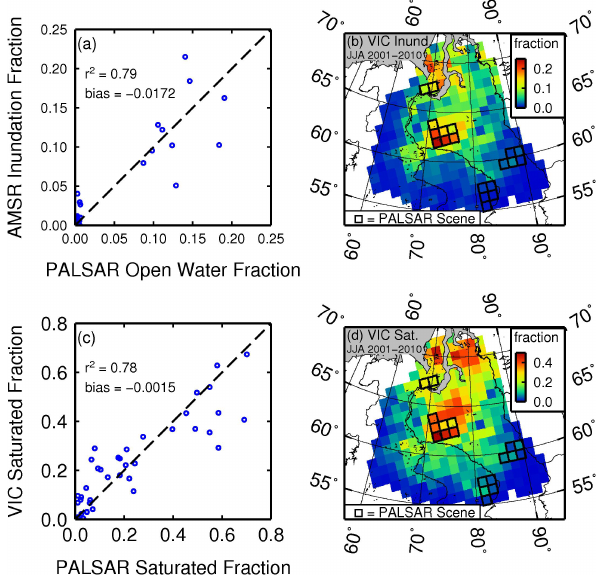
Fig. 3. Observed and simulated fractional extents of inundation and saturation over the West Siberian Lowland. Units are the fraction of the entire grid cell area (wetland plus